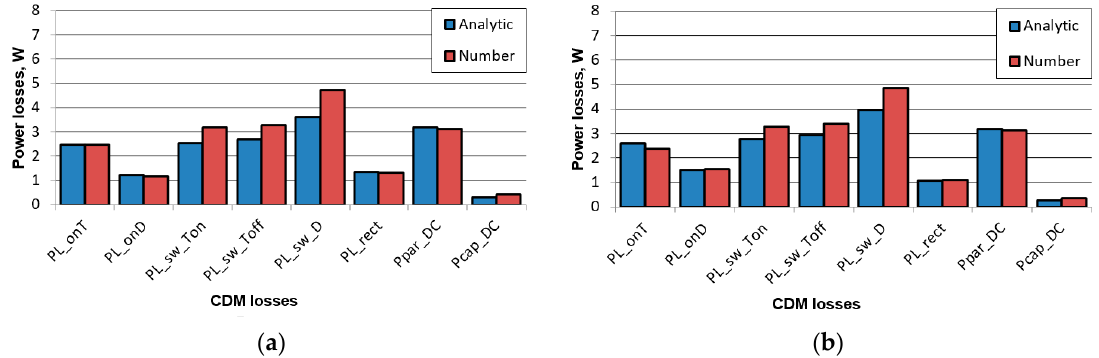
Figure 9. CDM losses using the analytical and the numerical methods for mode No. 1 of Table 2: ( a ) IM drive; ( b ) SynRM drive.